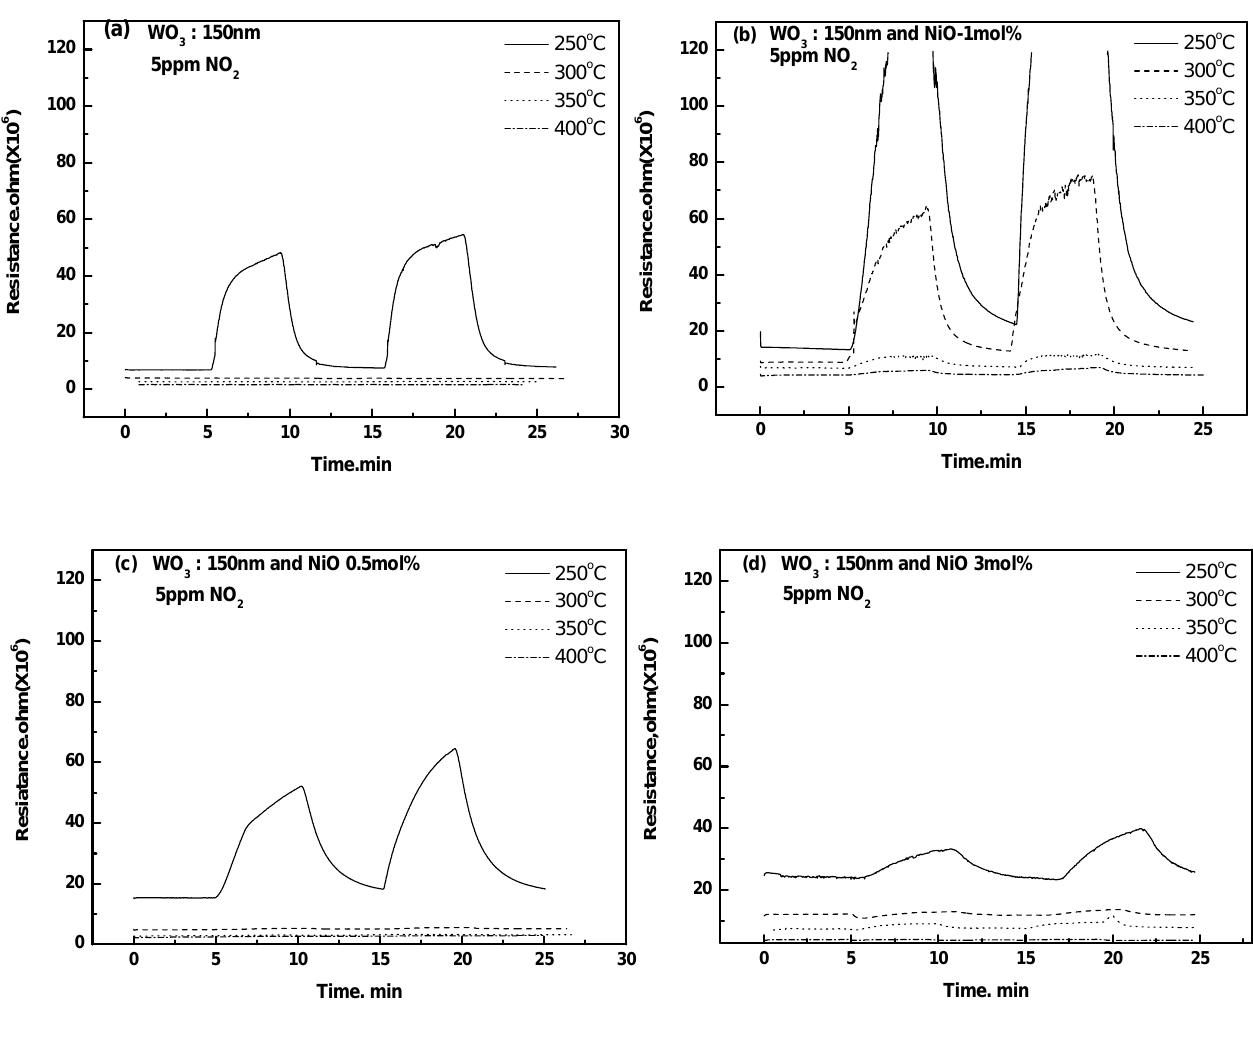
gas with time. (a) 150nm pure WO 2 (150nm) (d) NiO(3mol%):WO 3